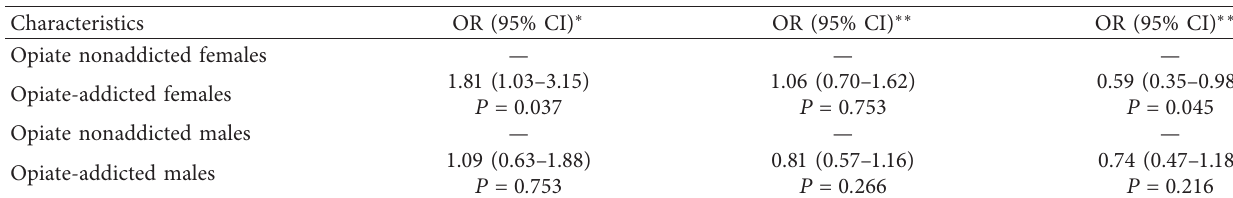
Table 2: Logistic regression.